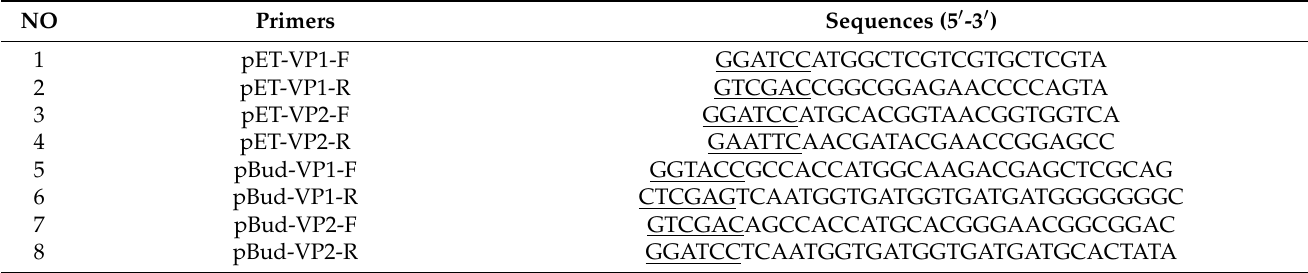
Table 1. Primer sequence used in this